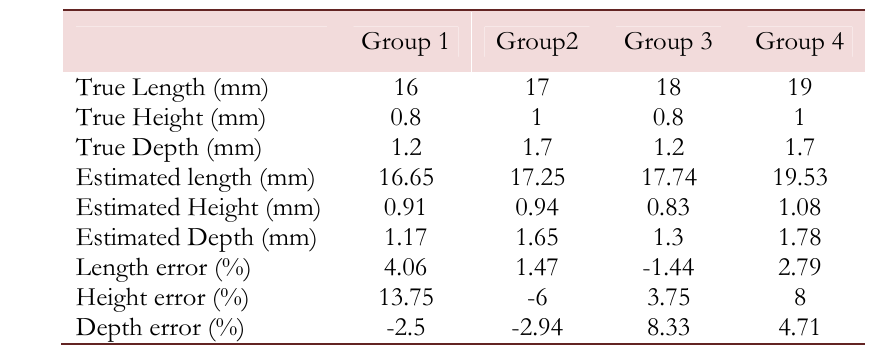
Table 5: Identification of defect using the least square